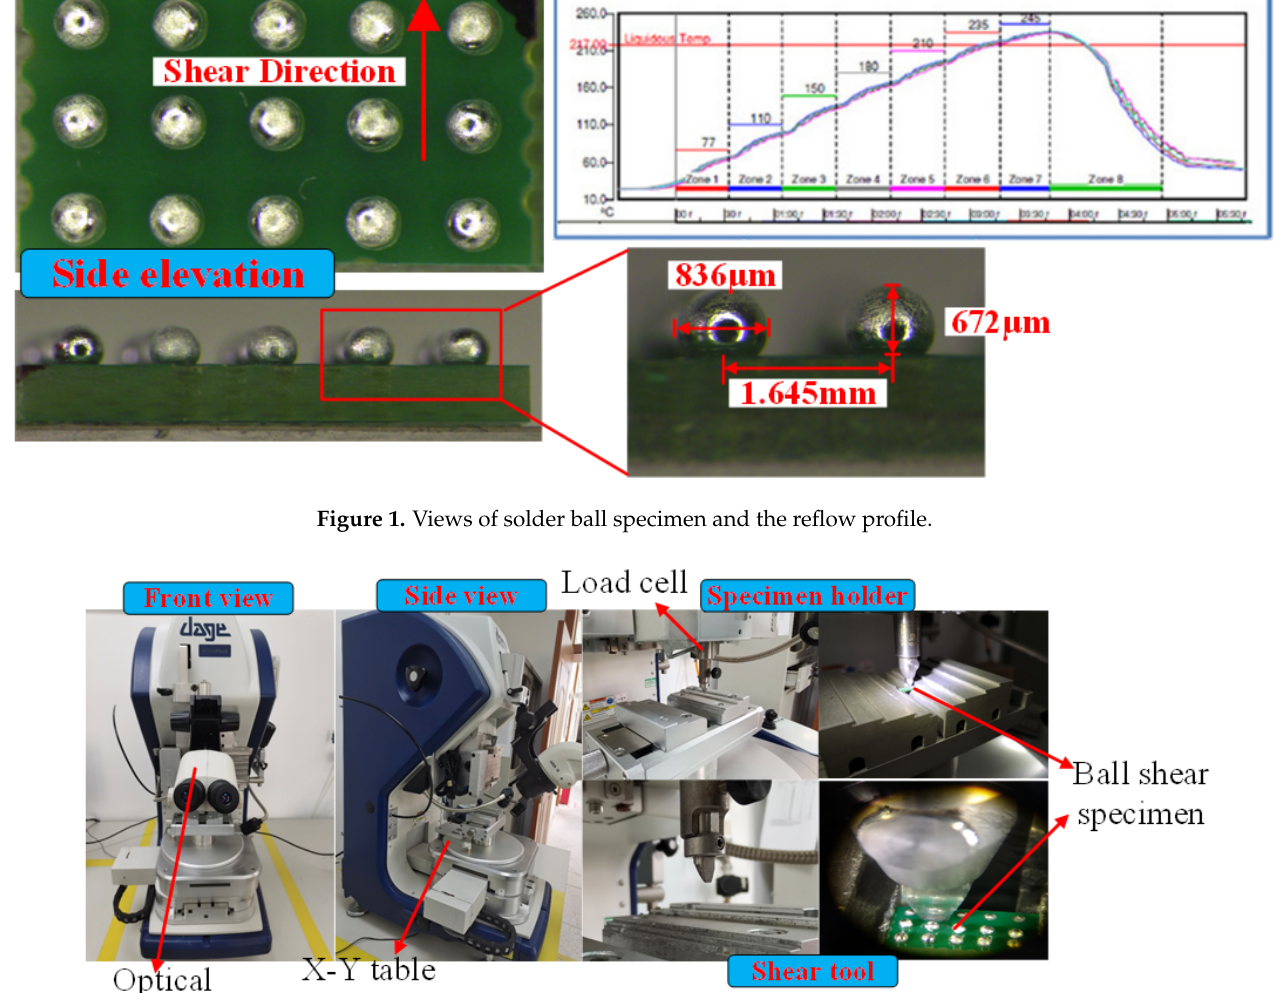
Figure 1. Views of solder ball specimen and the reflow profile.